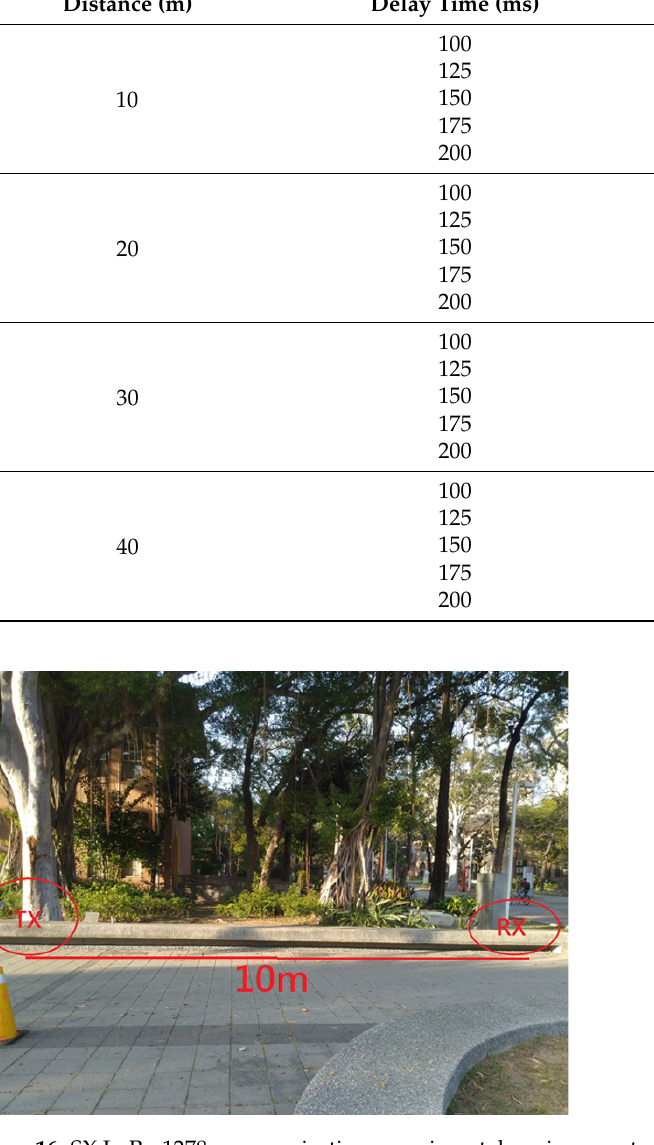
Figure 16. SX LoRa-1278 communication module experimental environment.